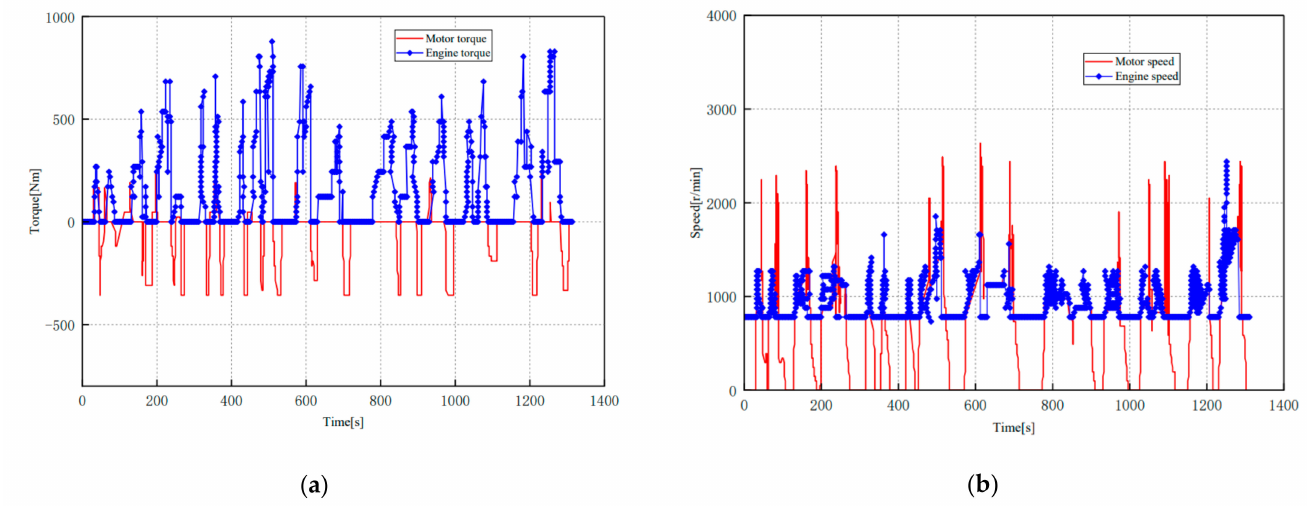
Figure 12. Comparison of torque and speed between engine and motor. ( a ) Engine and motor torque. ( b ) Engine and motor speed.